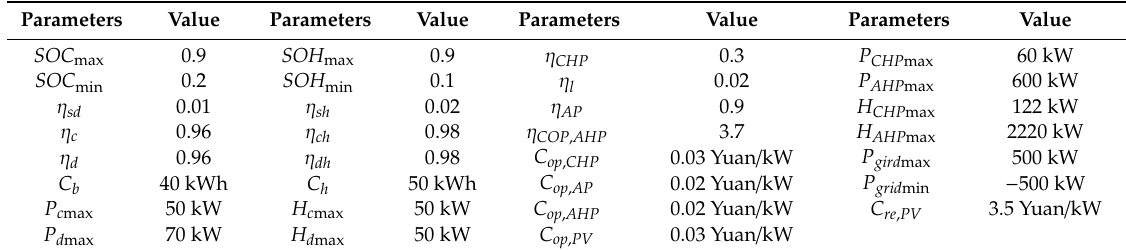
Table 12. Equipment parameters in micro-energy-grid.